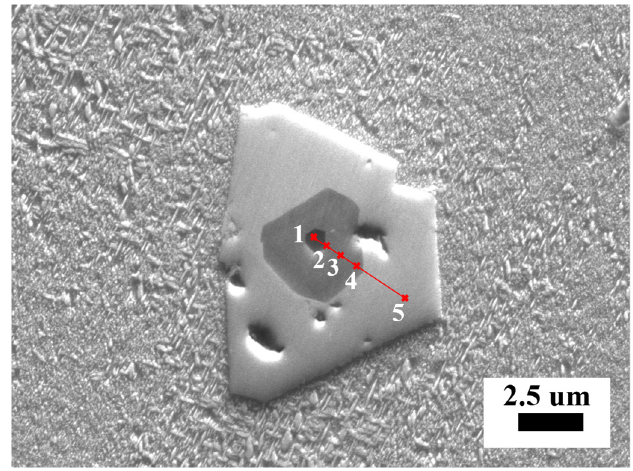
Figure 5. The morphologies and compositions of MCs were measured by EPMA-8050G (Acc V: 15.0 kV/BC: 19.4 nA). EPMA analysis of the chemical compositions of points 1 to 5. Table 4. The EPMA results of points number 1 to 5 are shown in Figure 5 (at%).